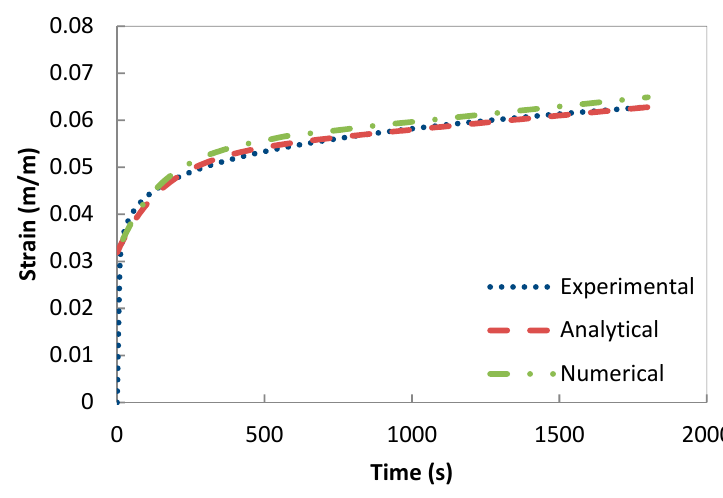
Figure 10. Modelling the creep component of C-PB5 by a Burger model.